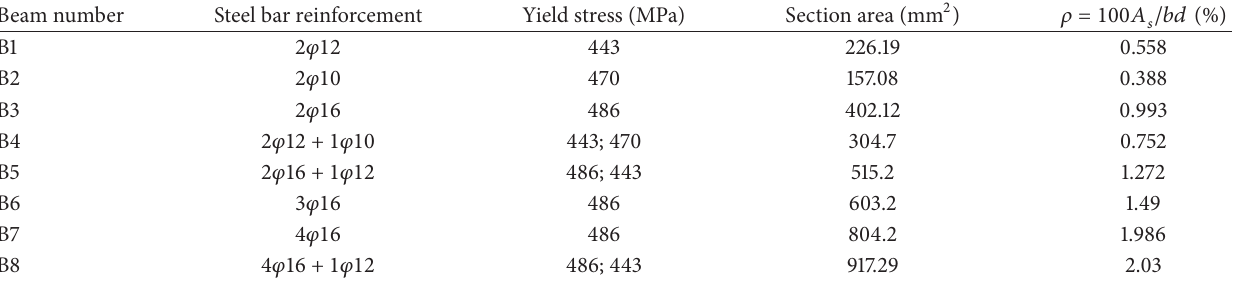
Table 5: Steel reinforcement details of R-SC-ECC